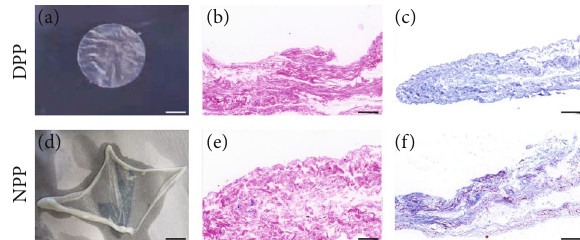
Figure 1: Histological analysis of (a – c) DPP and (d – f) NPP. (a, d) Macromorphology showed no signi fi cant di ff erence between DPP and NPP, but whitened in DPP. (b, e) HE staining demonstrated no remaining nuclear components in the porcine pericardium after decellularization. (c, f) Masson staining displayed no clear di ff erence in the morphology of collagen fi brils, organization into fi bers, or the overall architecture of the collagen matrix evident after decellularization; n = 3 . Scale bar (a – f): 50 μ